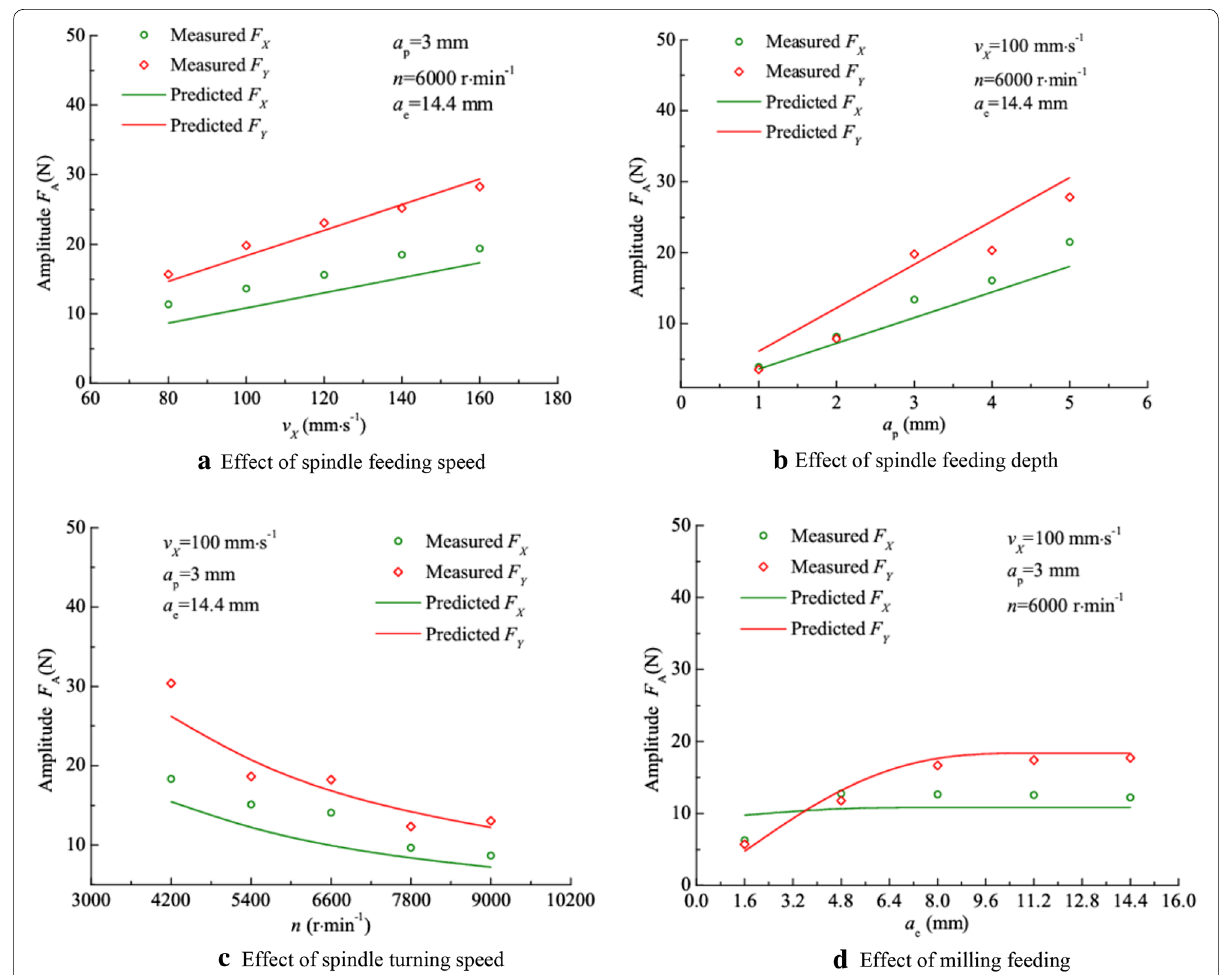
Figure 10 Comparison between predicted and measured amplitude of cutting